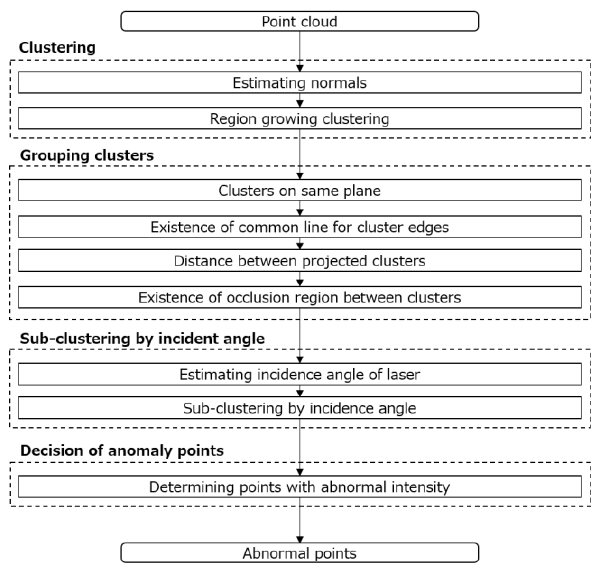
Figure 1. Processing flow of proposed